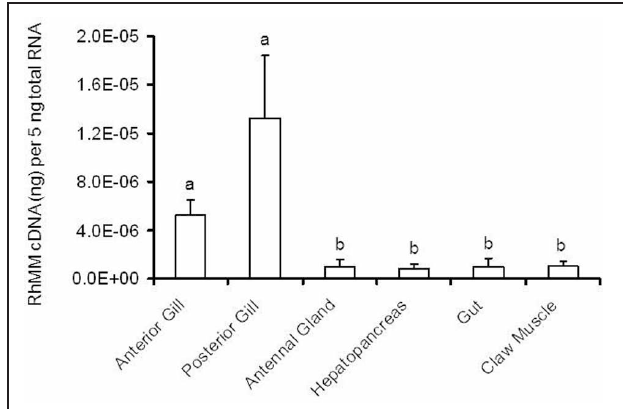
FIGURE 8 | Quantitative mRNA expression analysis of RhMM in various tissues of Metacarcinus magister . Significant differences of RhMM expression are indicated by different letters (a, b). Data were analyzed employing a One-Way Anova using a Tukey’s pair wise comparison. Data represent means ± SEM ( N = 3–5).